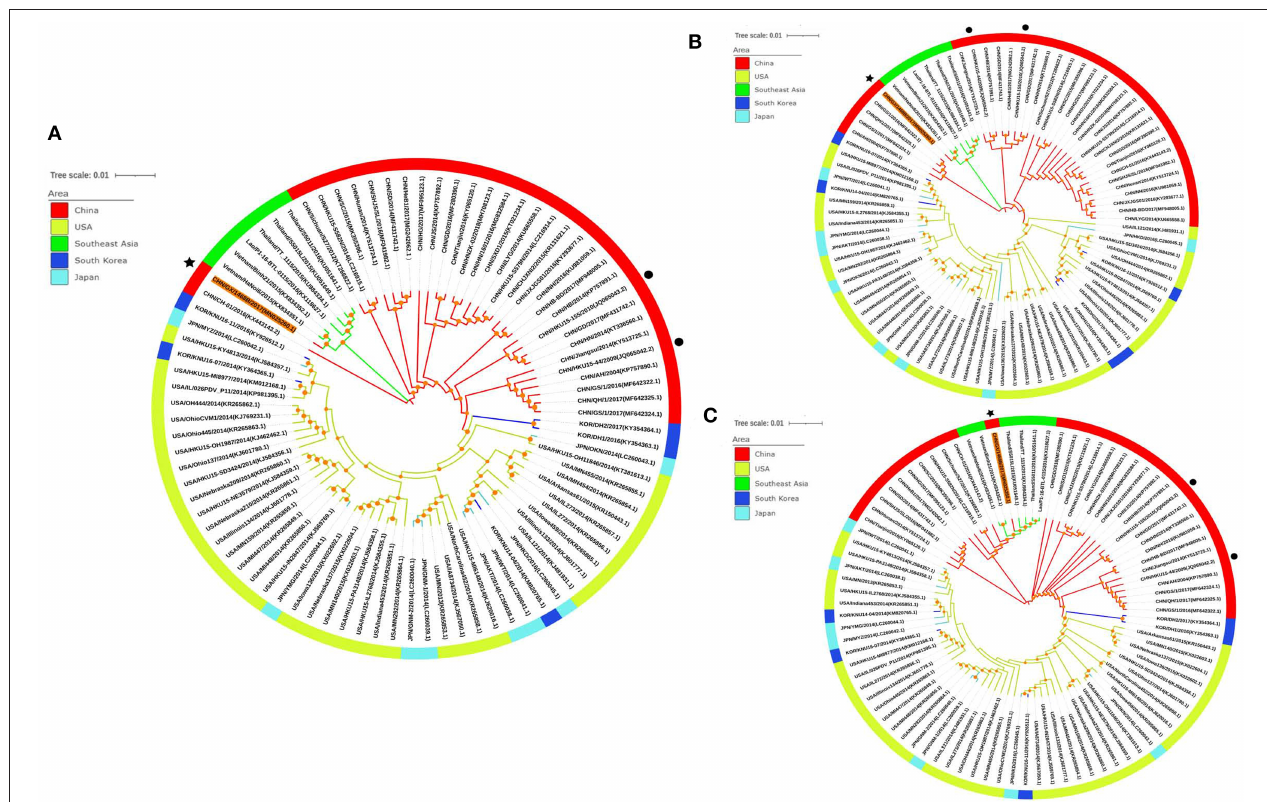
FIGURE 2 | Phylogenetic trees of PDCoV strains based on the sequences of the complete genome (A) and the S protein (B) and ORF1a/1b proteins (C) . Phylogenetic trees were constructed using the neighbor-joining method in MEGA6 software and a bootstrap analysis was performed with 1,000 replicates. The trees were visualized using the online software, iTOL (https://itol.embl.de/), and bootstrap values > 50% are shown at the branch points. Each PDCoV strain is indicated in the following format: country origin (CHN, China; JPN, Japan; KOR, South Korea; USA, the United States; Lao; Thailand and Vietnam)/strain name/year of collection (GenBank accession number). The CHN/GX/1468B/2017 strain obtained in this study is indicated with a black asterisk, the CHN/HKU15-44/2009 and CHN/HKU15-155/2010 strains originally identified in Hong Kong are indicated with a black dot. The branches in red, green, yellow, light blue, and dark blue represent the clades from China, Southeast Asia, USA, Japan, and South Korea,